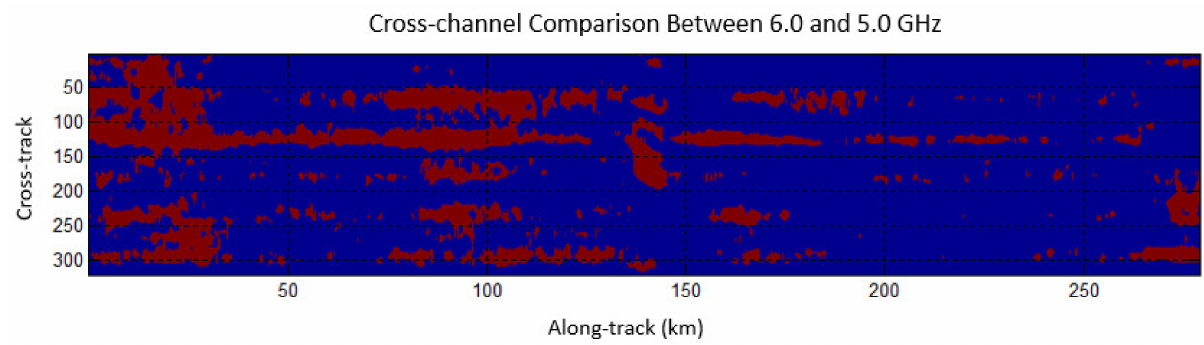
Figure 4. Channel 5 to 6 T B comparison using MSFC externally calibrated data for Leg 4 of Gonzalo, where the red pixels (Boolean logic 1) are erroneous (T B5 > T B6 ).